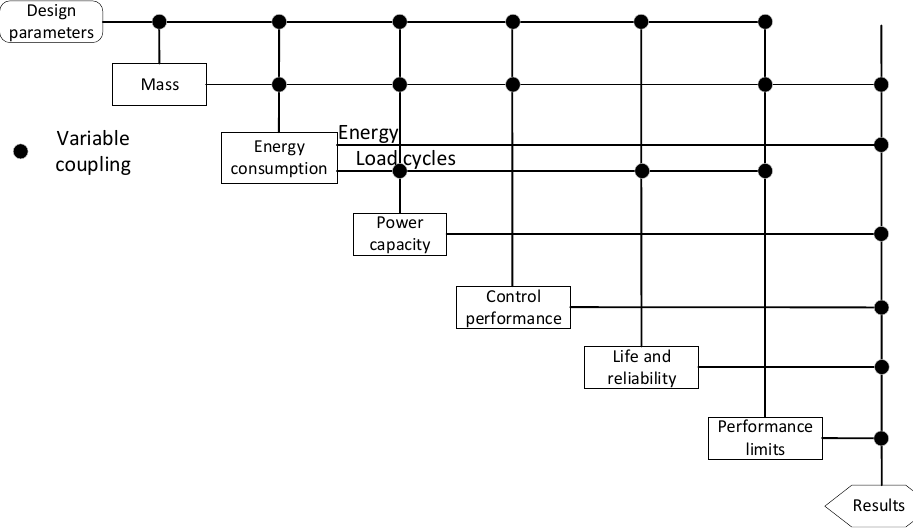
Figure 6. The design structure matrix of the calculation models of the objectives and